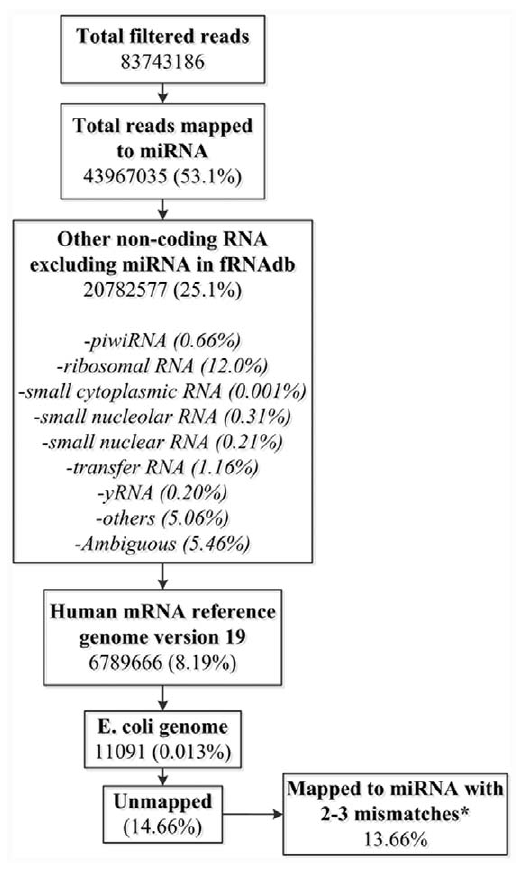
Figure 1. Flowchart depicting sequential mapping of the reads. As demonstrated, the unmapped reads were remapped to miRbase after relaxing the criteria to allow 2–3 mismatches leaving only , 1% of the reads unmapped. fRNAdb, functional RNA database version 3.4; ‘ambiguous’ represents those reads that mapped to multiple different non-coding RNA in the fRNAdb; ‘others’ includes unclassified ncRNAs in fRNAdb; * these miRNA were not included in the final analysis of differential